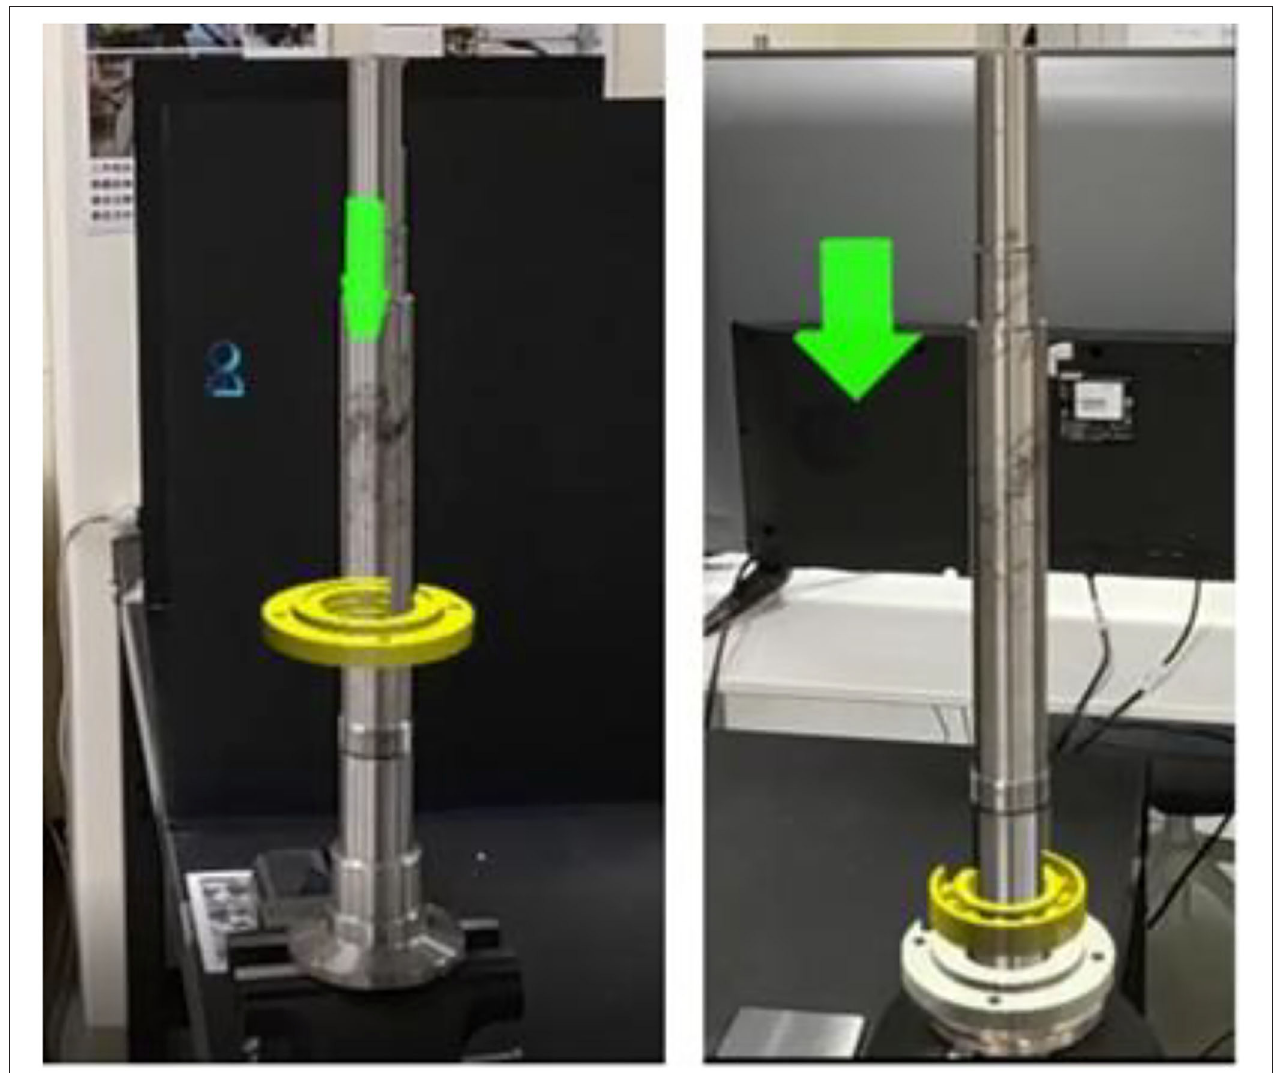
FIGURE 16 | Model animation positioning.